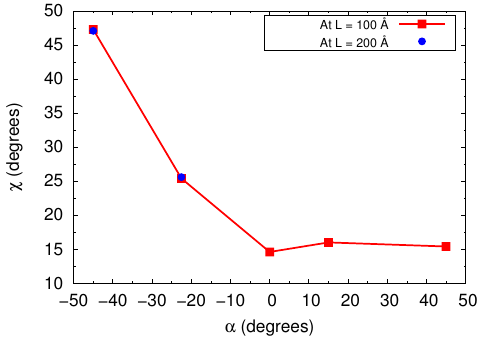
Figure 8. Force angle, χ , as a function of the rake angle α . For the negative rake angles, data were also obtained for a cutting length of 200 Å (circles); see Appendix